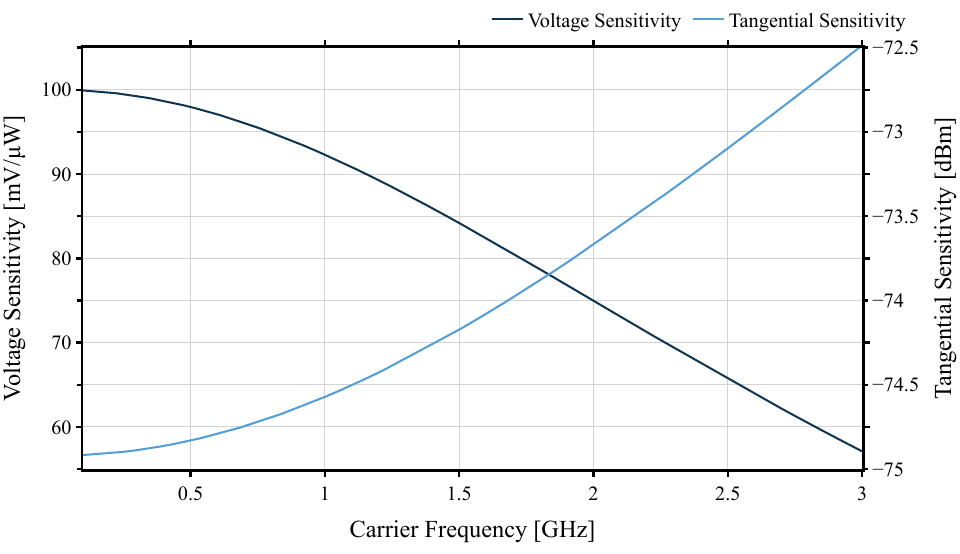
Figure 8. Voltage sensitivity and tangential sensitivity depending on signal frequency.